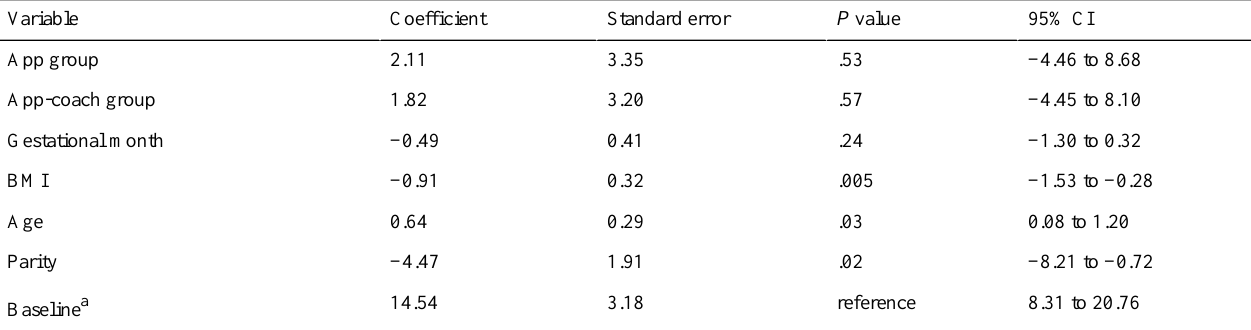
Table 2. Fixed-effect estimates from the linear mixed model investigating activity